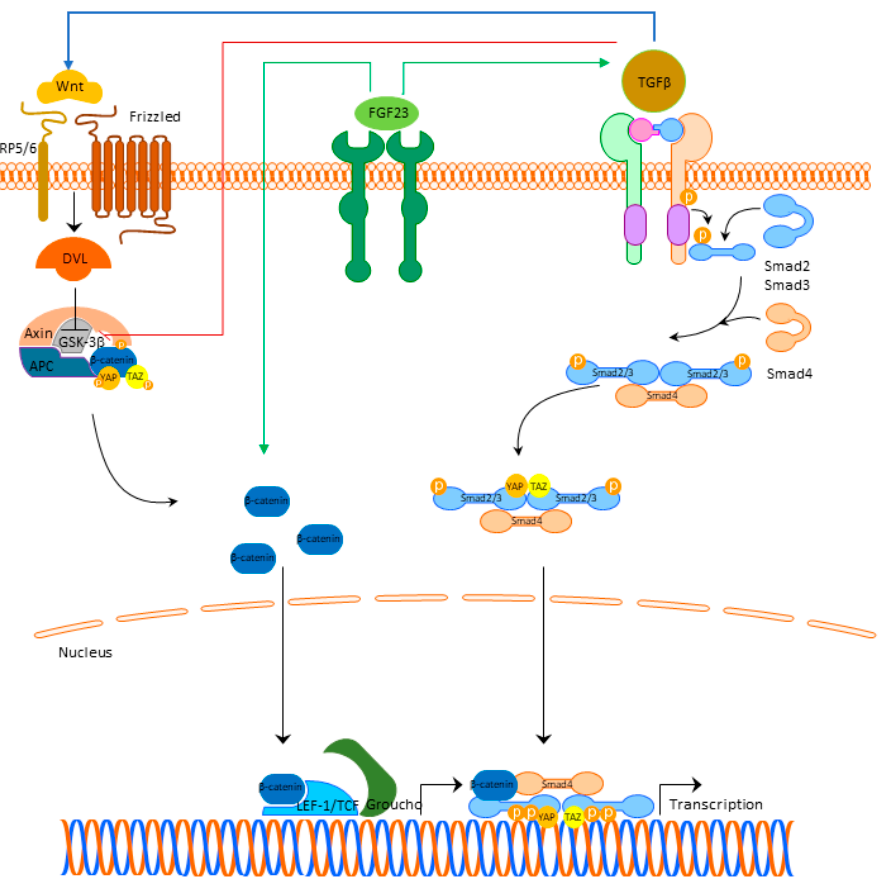
Figure 2. FGF23 signaling and cardiac fibrosis. Abbreviations: FGF23—fibroblast growth factor 23, FGFR4—fibroblast growth factor receptor 4, LRP 5/6—lipoprotein-receptor-related proteins 5 and 6, DLV—Disheveled protein, APC—Adenomatous Polyposis Coli, GSK3 β —glycogen synthase